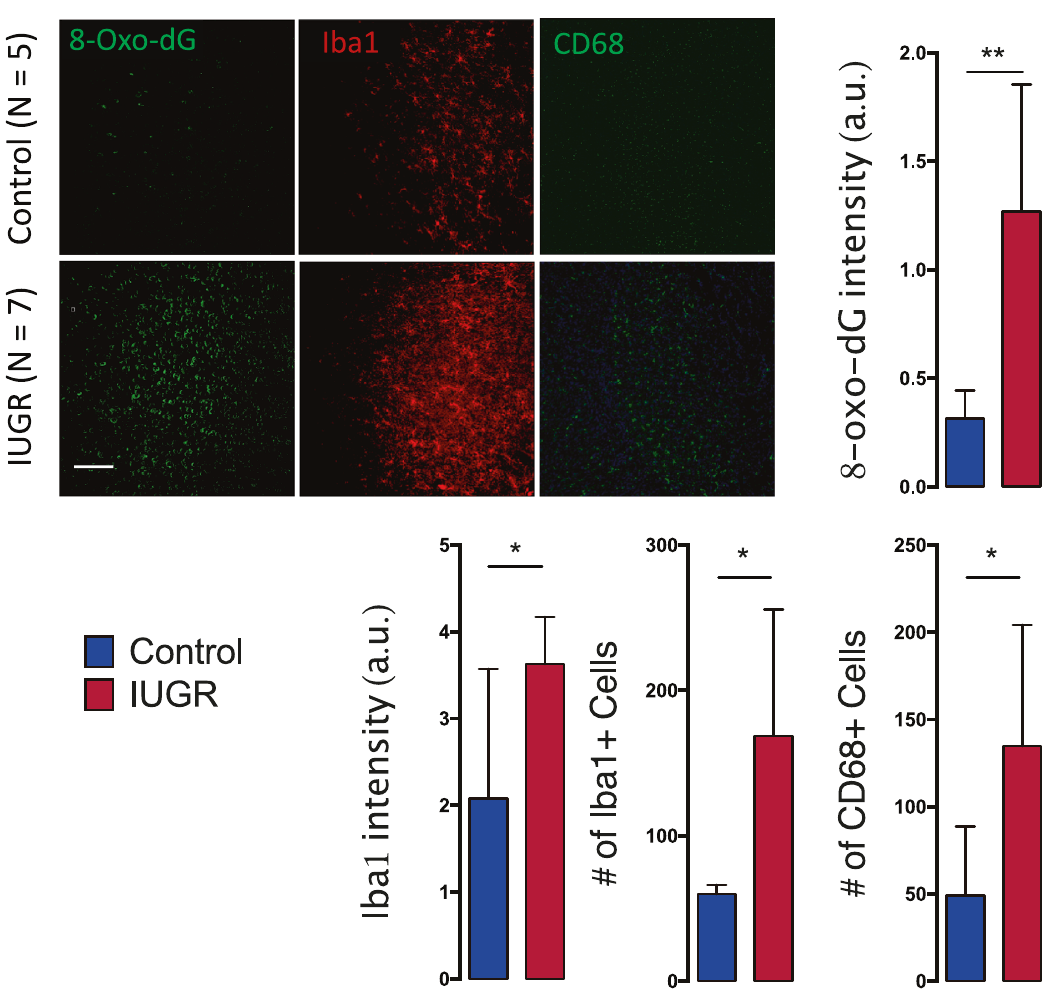
Fig. 1 Increased oxidative stress and microglia activation in the low protein induced IUGR offspring at P35. Images for 8-oxo-dG (label for mitochondrial DNA oxidation), Iba-1 (label for microglia) and CD68 (label for activated microglia) in both control ( n = 5) and IUGR ( n = 7) groups. IUGR leads to signi fi cant increase in 8-oxo-dG intensity (a.u.), Iba-1 intensity (a.u.) and Iba-1 cell count, as well as CD68 cell count in the ACC as compared to controls. Results are mean ± STD, * p = 0.05, ** p < 0.01, **** p < 0.0001 Control vs IUGR. Scale bar: 60 μ